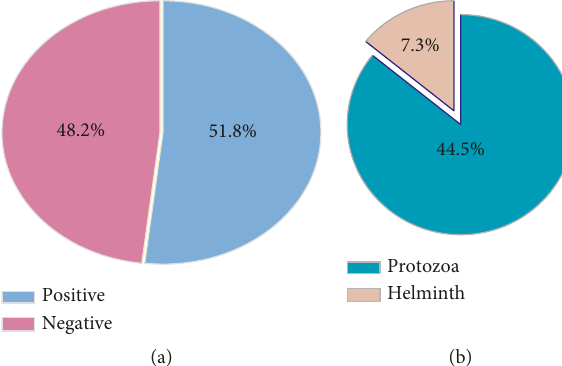
Figure 2: (a) Infected and noninfected participants. (b) The prevalence of intestinal parasites.